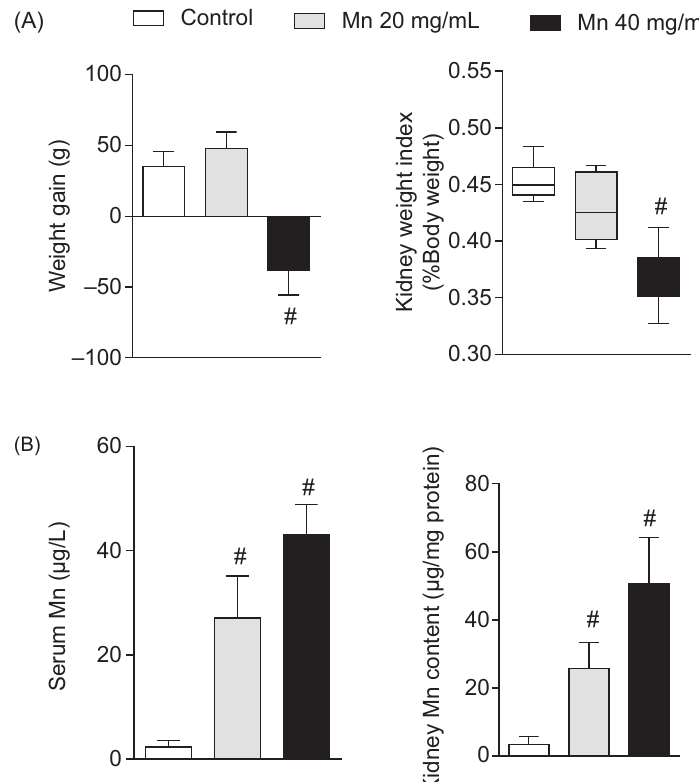
Figure 1 . Effect of manganese treatment (20 and 40 mg/mL for 30 consecutive days) on animals’ weight gain, renal weight index (Panel A), and serum and kidney tissue manganese (Mn) (Panel B). Data are shown as mean ± SD (n = 8). # Indicates significantly different as compared with the control group (P < 0.05).